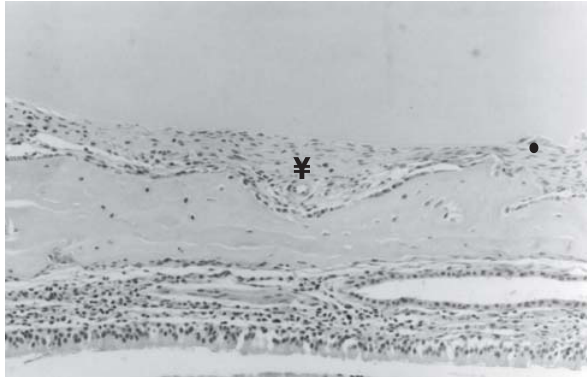
FIGURE 1- Group I, 15 days - dense connective tissue oriented in parallel direction to the root surface (¥) and small resorption lacunae (€)